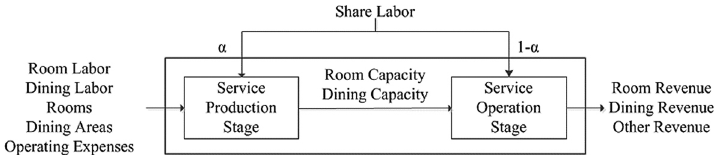
Figure 1. The two-stage managerial performance framework of international tourist hotels in